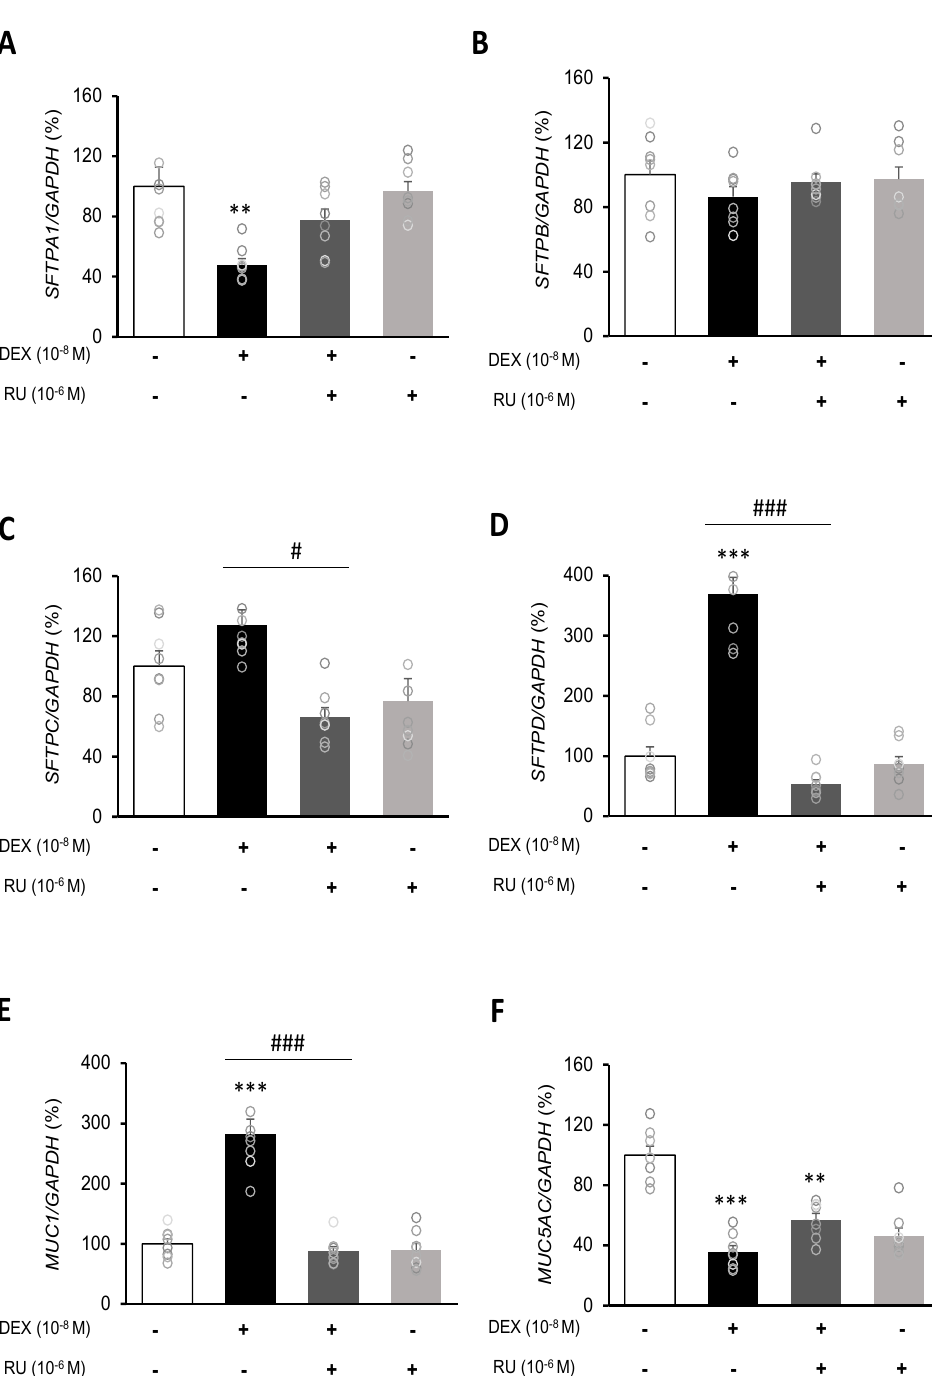
Figure 5. Regulation of surfactant protein and mucin genes expressions by dexamethasone in A549 cells. E ff ect of DEX and its antagonist (RU486) on the transcriptional level of ( A ) surfactant protein A (SFTPA1), ( B ) surfactant protein B (SFTPB), ( C ) surfactant protein C (SFTPC), ( D ) surfactant protein D (SFTPD), ( E ) mucin 1 (MUC1), and ( F ) mucin 5AC (MUC5AC) by real-time PCR. The mRNA level was measured by performing real-time PCR and was normalized by GAPDH. ** p < 0.01 versus Control; *** p < 0.001 versus control; # p < 0.05 versus DEX; ### p < 0.001 versus DEX.